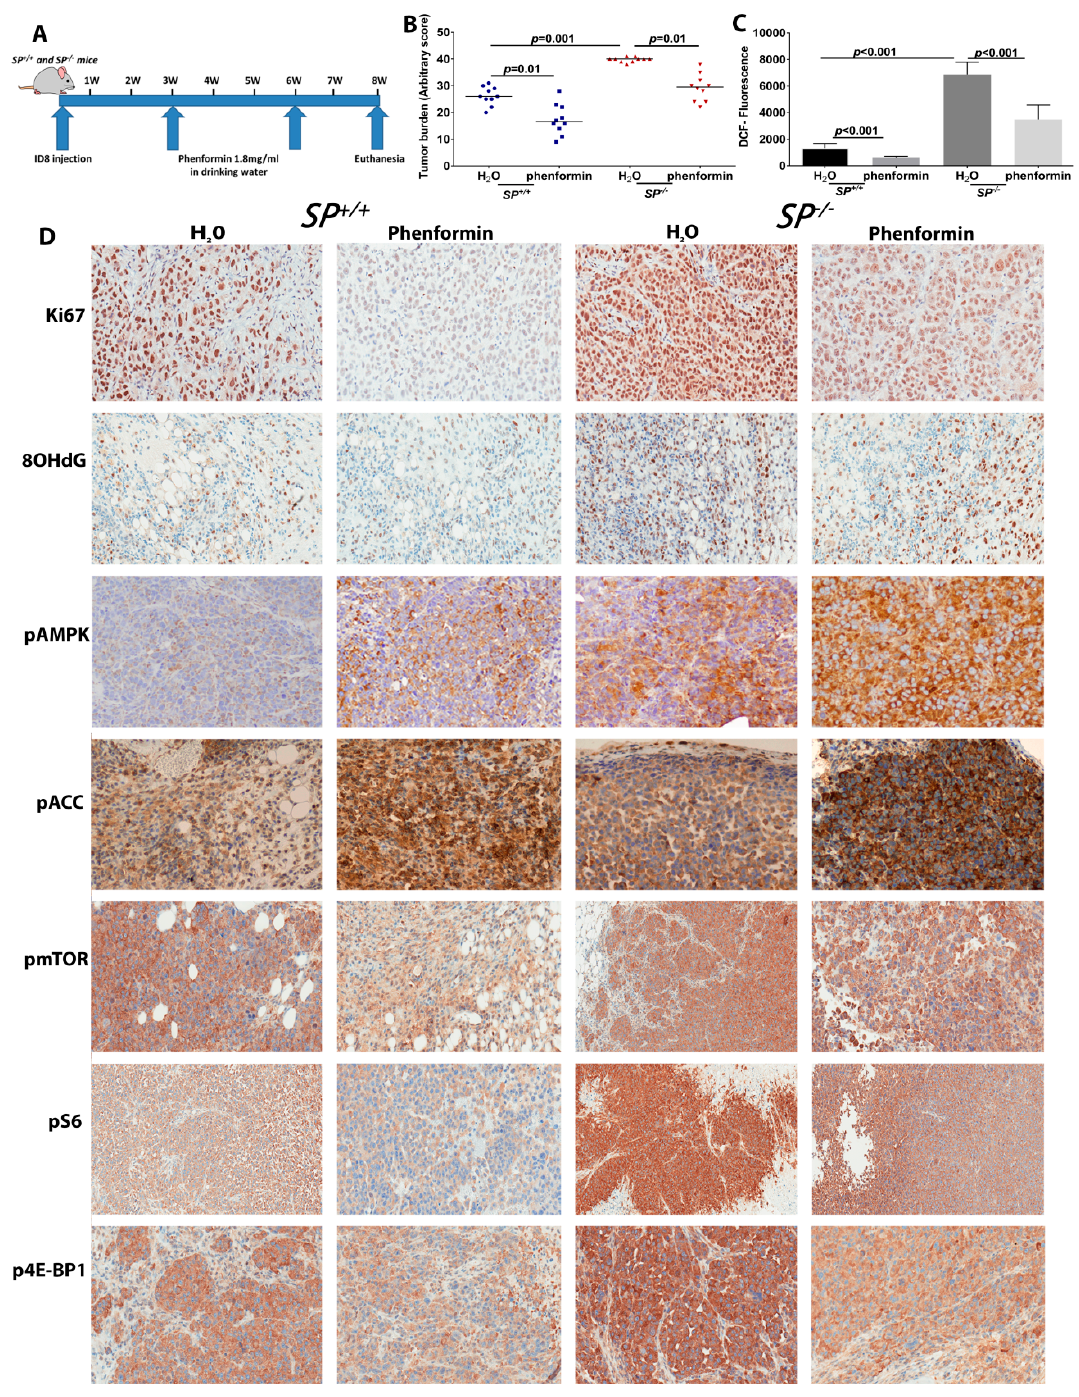
Figure 9. Effect of phenformin on syngeneic ID8 tumors in SP − / − and SP +/+ mice. ( A ) Schema of the mouse therapeutic trial with phenformin. ( B ) Scatter plots showing the effect of phenformin on syngeneic tumor burden in SP − / − and SP +/+ mice. p < 0.05. ( C ) Bars depict mean ± SEM of the levels of H 2 O 2 in syngeneic tumors determined by DCF fluorescence. p < 0.05, Student’s t -test. ( D ) Immunostaining of syngeneic tumors with the indicated antibodies (200×).